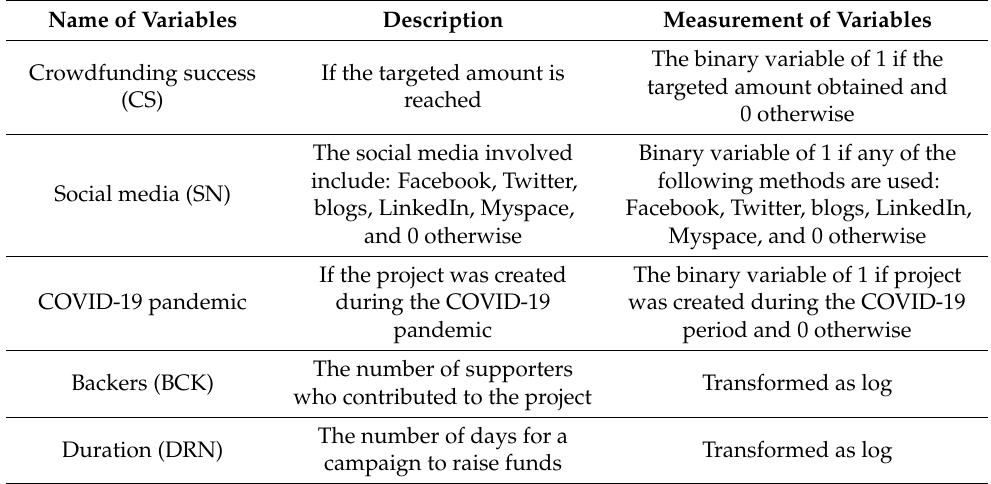
Table 4. Variable Description and Measurement.